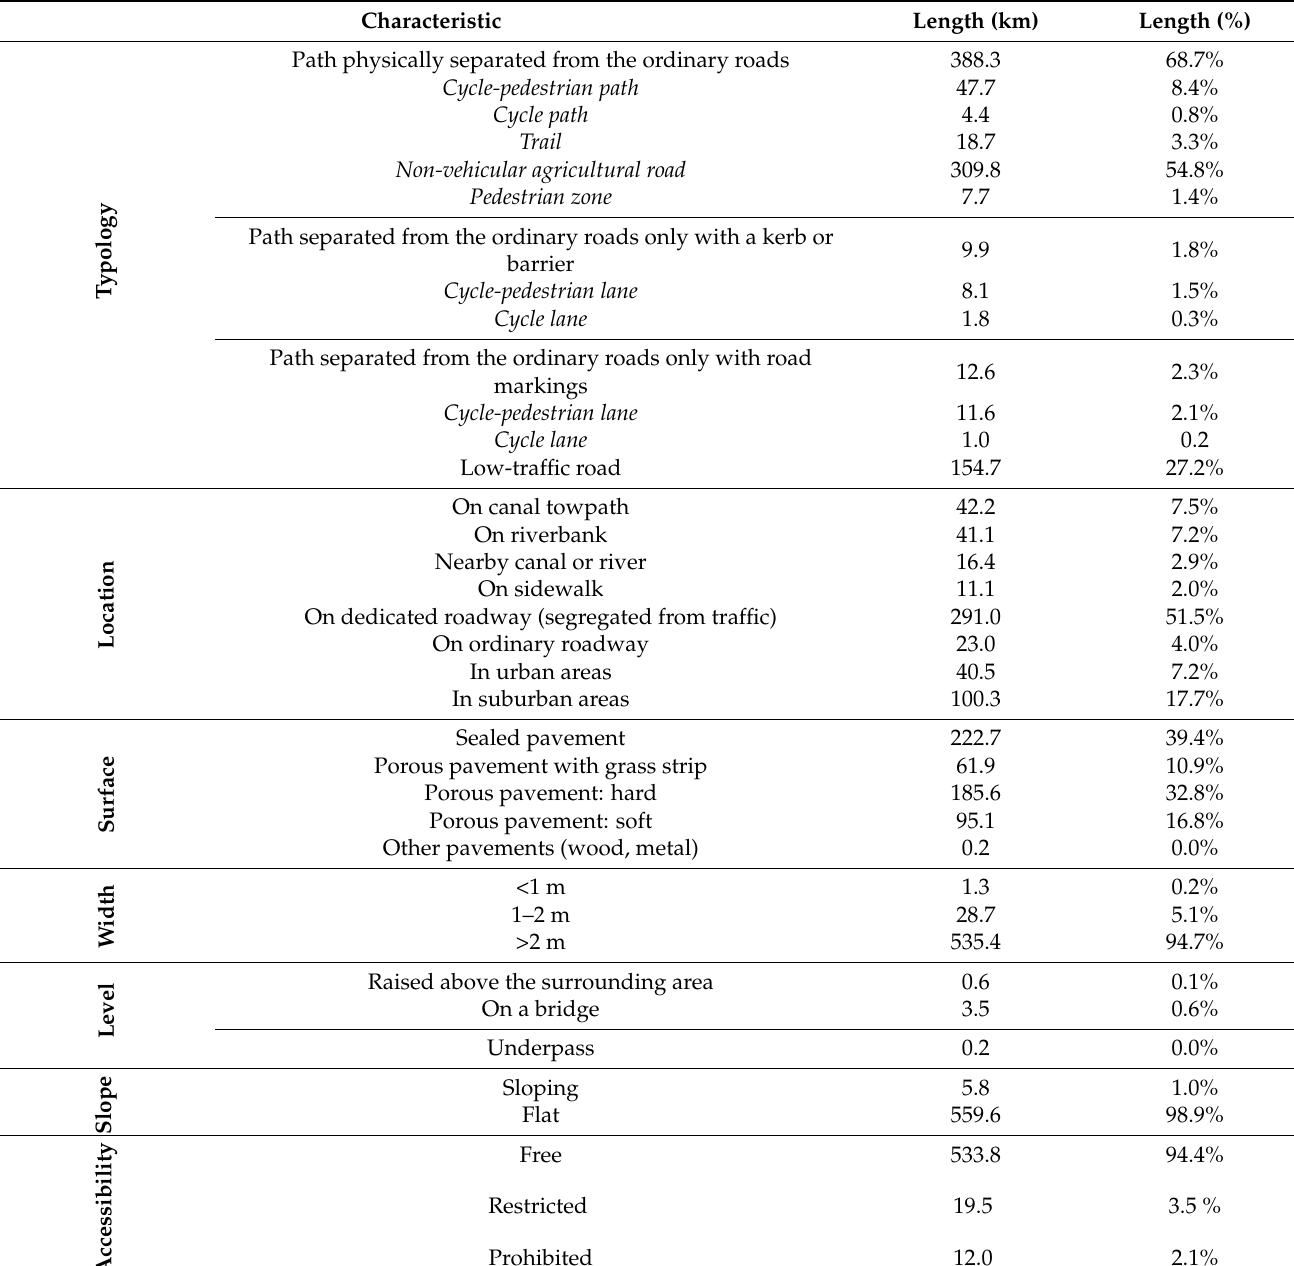
Table 2. Classification of the surveyed